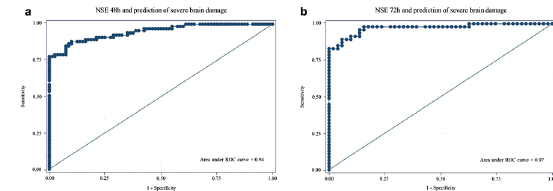
Fig. 1 NSE Receiver‑Operating